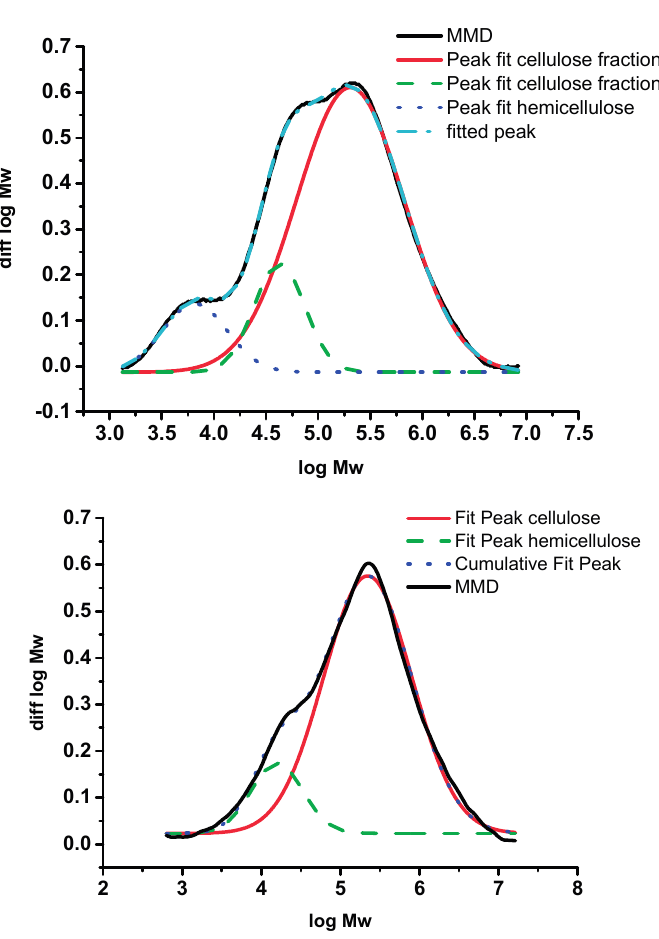
Figure 5. MWD of a hardwood pulp ( top ) and a softwood pulp ( bottom ) with multiple-peak fits of the cellulose and hemicellulose fraction